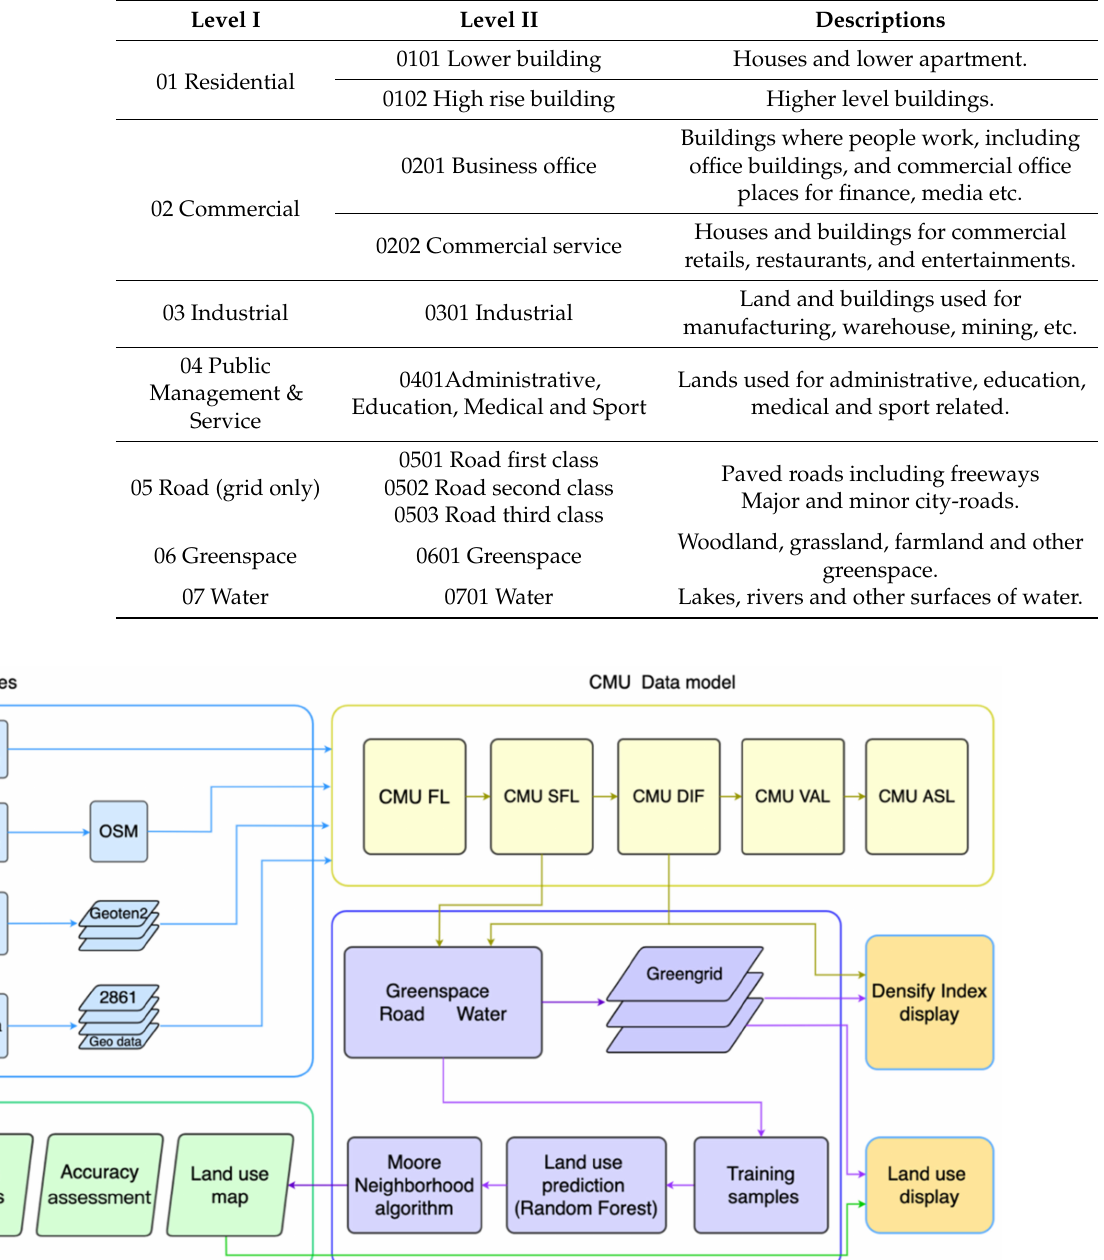
Table 1. Land Usage Classification (GULUC/PULUC).